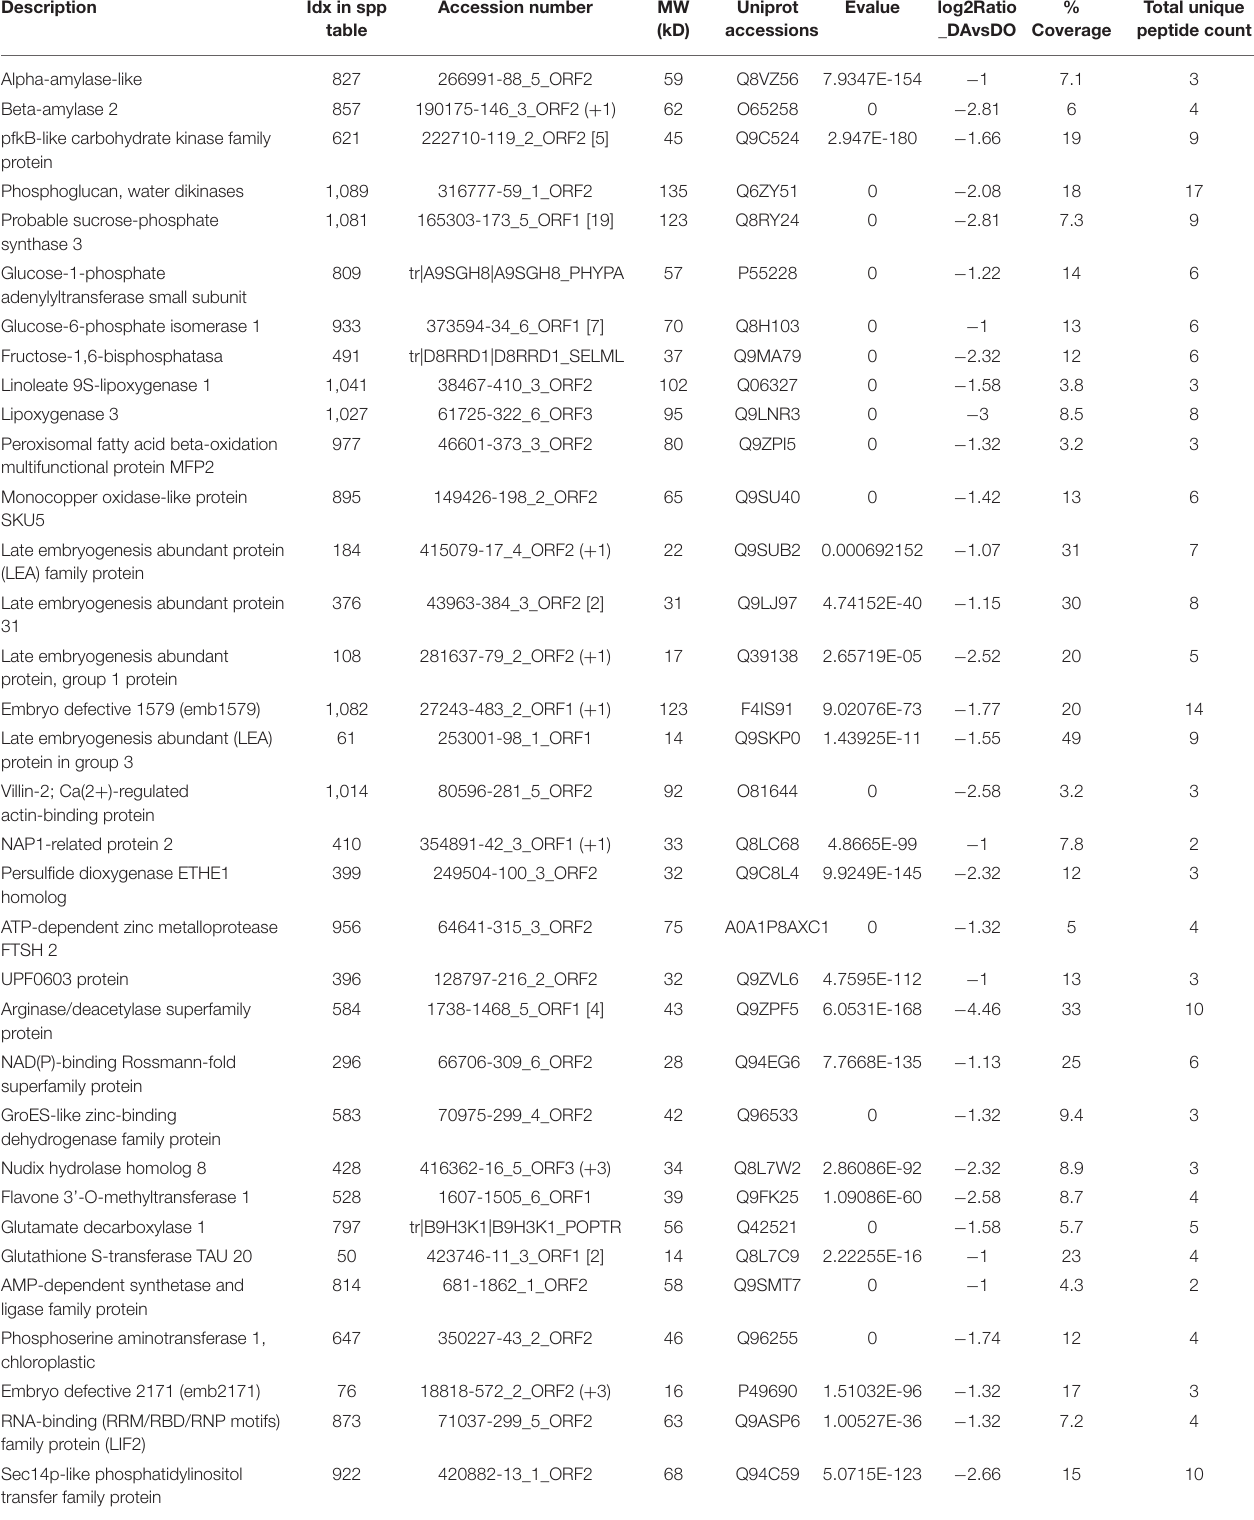
TABLE 2 | Selected proteins upregulated in the sexual fern Dryopteris oreades